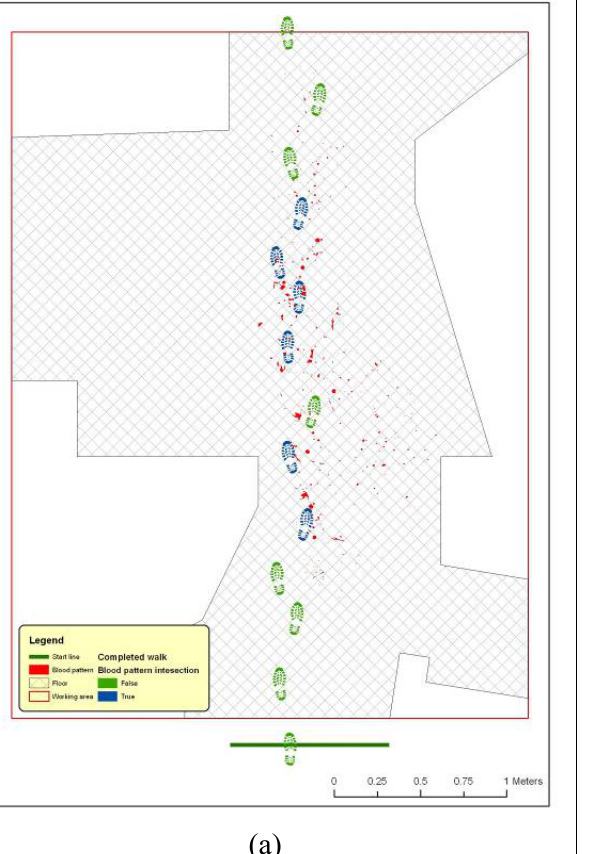
Figure 18 . Software workflow, step 5. (a) Completed walk, with computed intersection with bloodstains.;(b) uncompleted walks, with computed intersection with